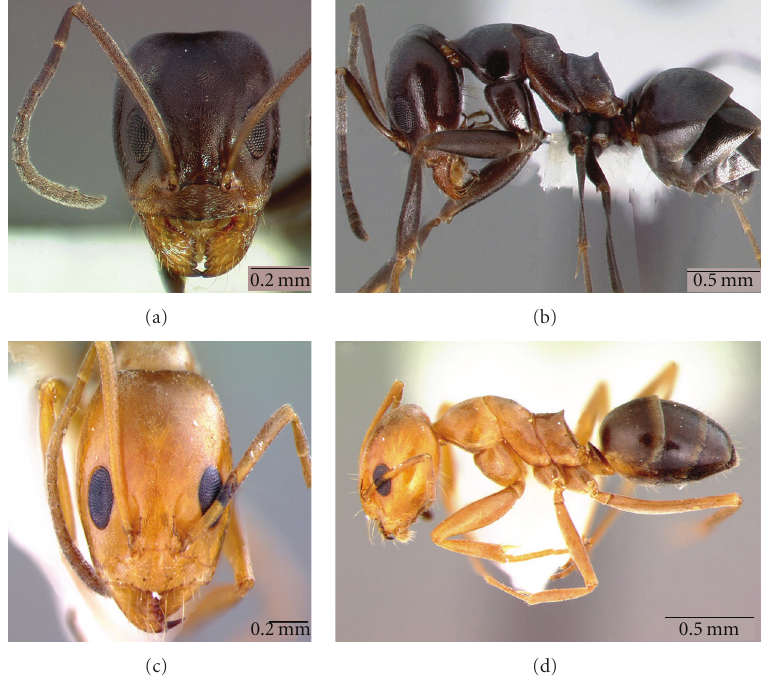
Figure 9: Dorymyrmex workers. (a) and (c) Heads of (a) Dorymyrmex insanus ; (c) Dorymyrmex pyramicus ; (b) and (d) body profiles of (b) Dorymyrmex insanus ; (d) Dorymyrmex